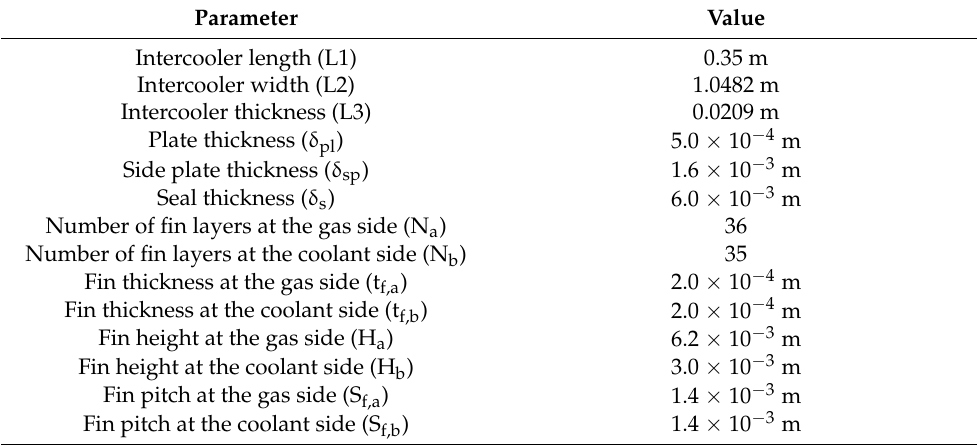
Table 1. Constructional data of the modelled